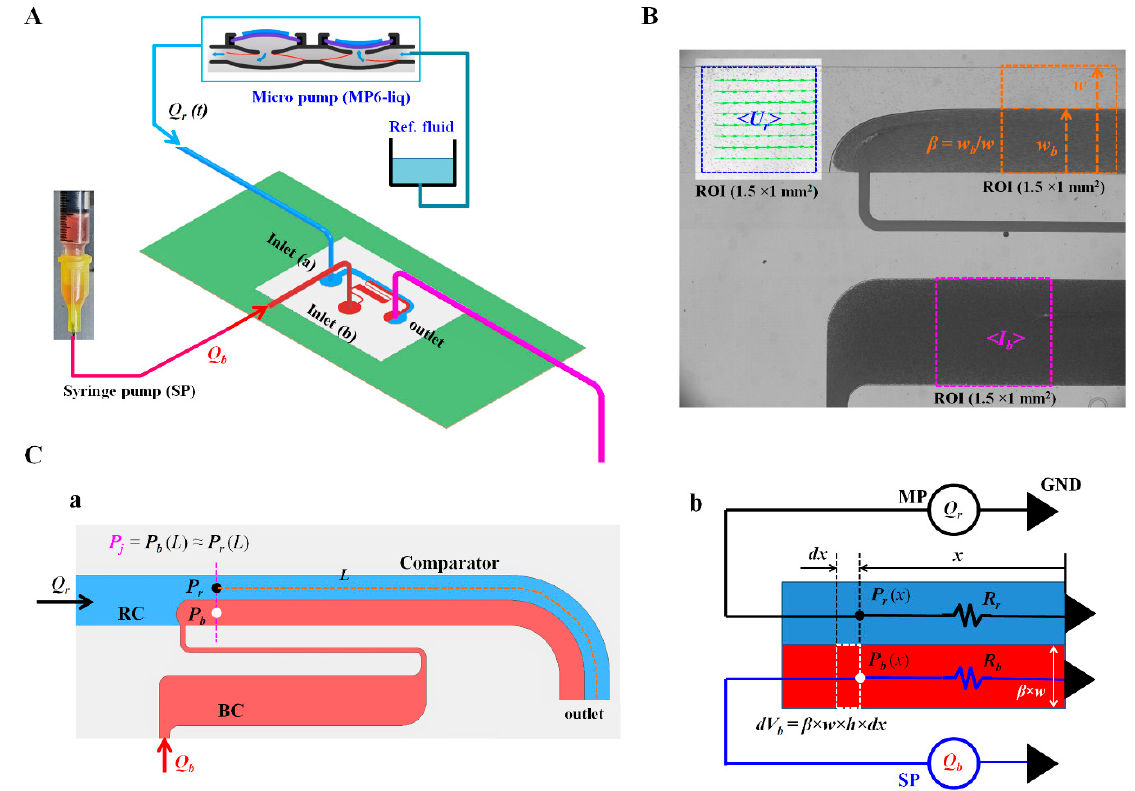
Figure 1. The proposed method for quantifying blood biophysical properties by analyzing blood flows in a microfluidic device. ( A ) Schematic diagram of the proposed method. The method employed a microfluidic device, micropump for supplying reference fluid, and syringe pump for delivering blood. ( B ) Quantification of three parameters (i.e., < U r >, < I b >, and β ). Each parameter was arithmetically averaged over a specific region of interest (ROI) (1.5 × 1 mm 2 ). ( C ) Analytical representation of the blood biophysical properties using a discrete fluidic circuit model. ( a ) Junction pressure of each fluid stream in the comparator with length ( L ). Both streams had the same pressure (i.e., P j = P r [ L